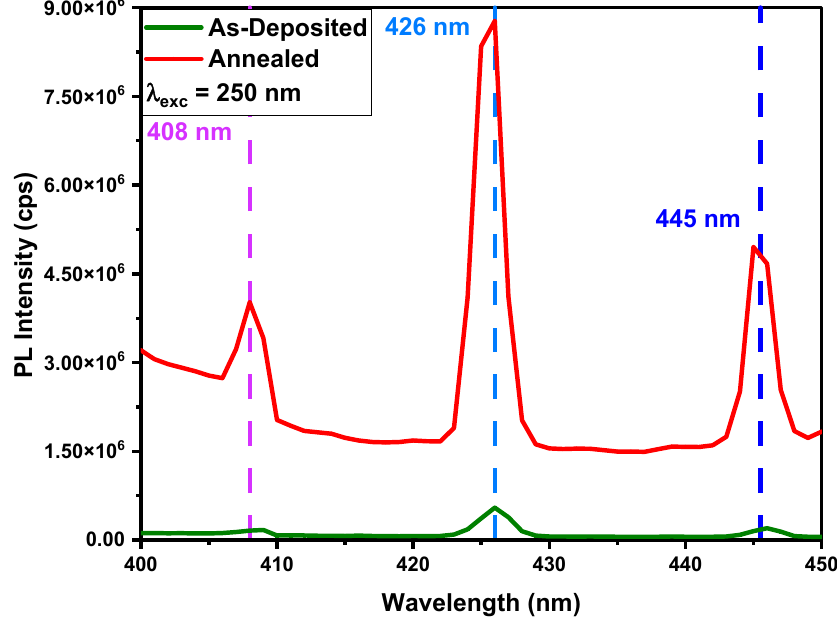
Figure 6. PL emission spectrum of as-deposited and annealed Ni-doped AlN thin films at an excitation wavelength of 250 nm.